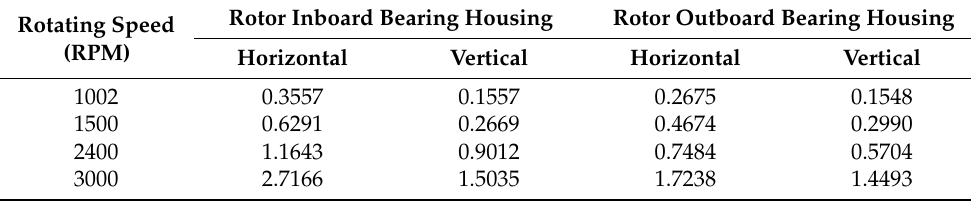
Table 3. Overall velocity-RMS (mm/s) with installing a bearing loader at no-fault condition. Rotating Speed